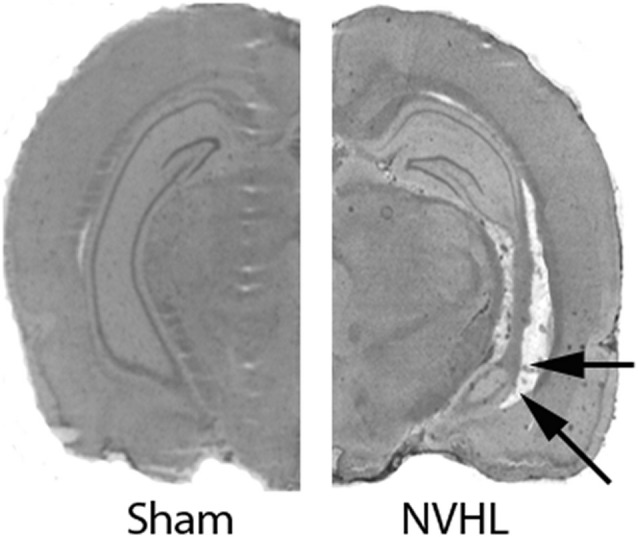
Verification of neonatal ventral hippocampus lesion (NVHL). Cresyl violet stained representative images showing an intact VH in sham animals (left). NVHL brain (right) shows cell loss, cavity and disorganization in the VH (as shown by arrows).